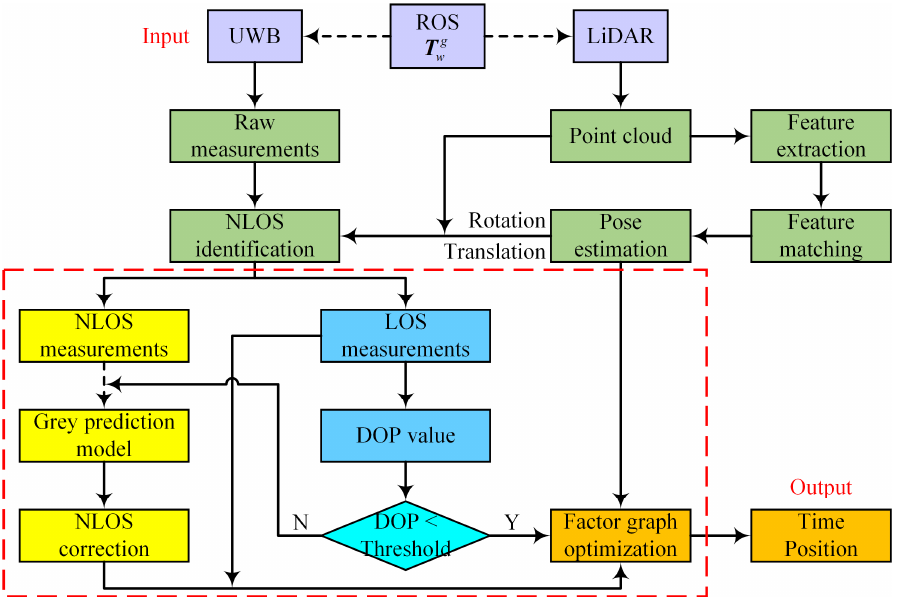
Figure 1. Framework of the proposed UWB/LiDAR-SLAM integrated system with NLOS identifi- cation and correction using a grey prediction model.